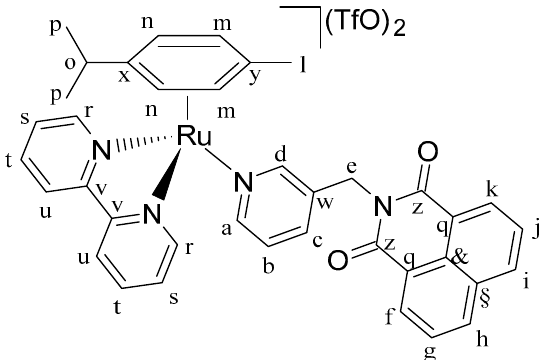
Figure 15 Structure of complex C1. Figure 15. Structure of complex [( η 6-p-cym)Ru(N,N’-bpy)(L1)](SO3CF3)2 (C1) .